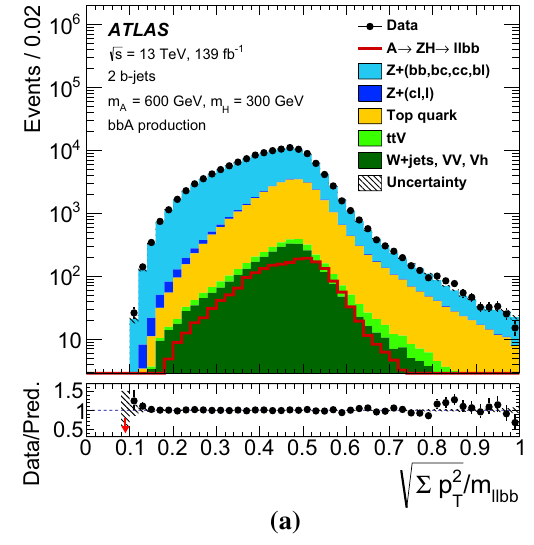
(cid:10) p 2 / m (cid:6)(cid:6) which includes both statistical and systematic components, in the back- bb distributions shown before the requirement T ground prediction (hatched area). The notations ttV , V V and Vh refer on this variable is applied for events with a exactly two b -jets and to top-pair production in association with a vector boson, diboson pro- b three or more b -jets. Corrections from a fit to the data are applied duction and SM Higgs boson production in association with a vec- to the simulation, as described in Sects. 5.1 and 8. The signal distri- tor boson, respectively. The production of a Z boson in association bution for ( m A , m H ) = ( 600 , 300 ) GeV is also shown, and is nor- with jets is split based on jet flavour. The notation Z+(bb,bc,cc,bl) malised such that the production cross section times the branching refers to the case where the jets originate from heavy flavour, which ratios B ( A → Z H ) and B ( H → bb ) corresponds to 1 pb. The includesatleastonejetoriginatingfroma b -quarkortwojetsoriginating signal shown includes only A bosons produced in association with from c -quarks, whereas the notation Z+(cl,l) includes all the remaining b -quarks. The lower panel shows the ratio of the data to the back- ground prediction (black filled circles) and the relative uncertainty,